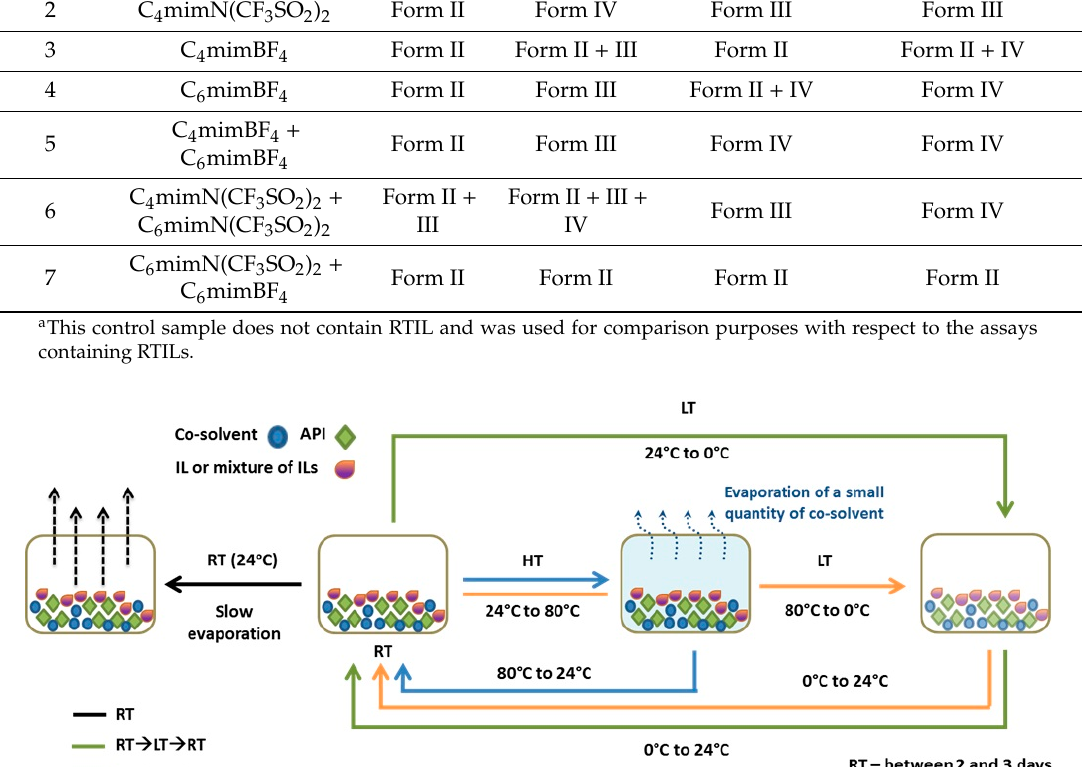
Table 1. Gabapentine polymorphic forms identified by single crystal XRD data [44].